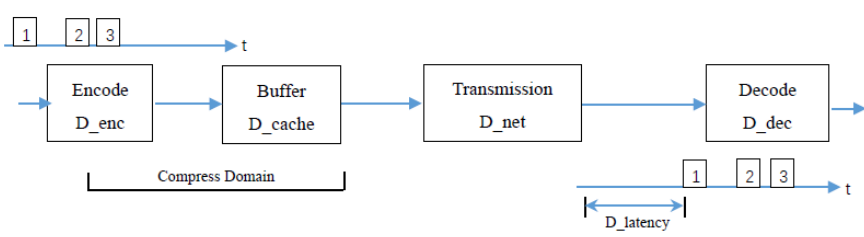
Figure 1. Video transmission delay distribution. The squares 1–3 marked in the figure are the video frames transmitted.